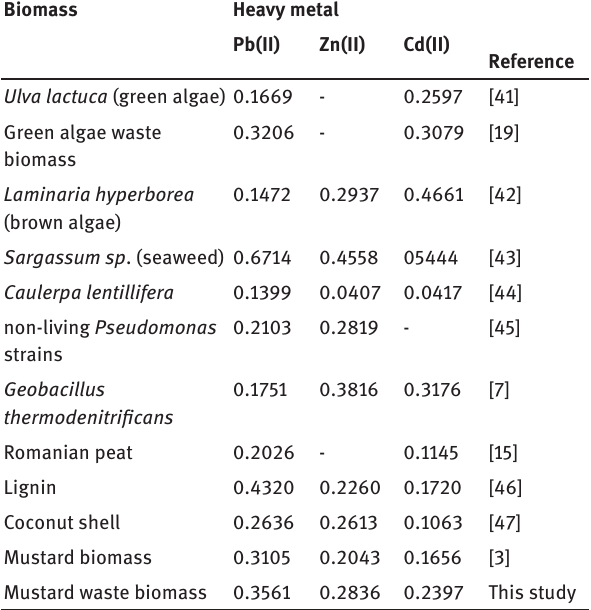
Table 7: Comparative values of maximum biosorption capacities (q mmol/g) for three heavy metals on various biomasses, at room max temperature (20 ± 3